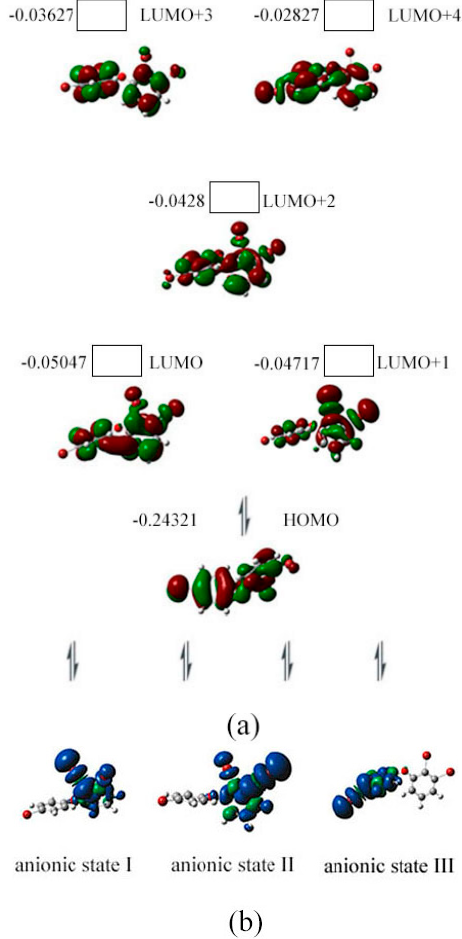
Figure 5. Orbital energy (hartree), HOMO, LUMO ( a ) iso-surface value = 0.02 au, degeneracy threshold = 0.01 hartree) for BDE-22 and its spin density ( b ) iso-surface value = 0.0004 au) surface image in gas phase.